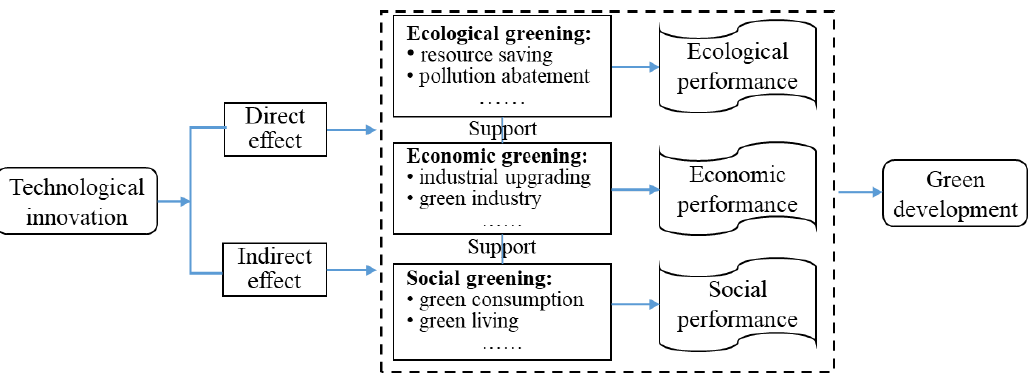
Figure 1. Research framework of the effect of Technological Innovation on green development.